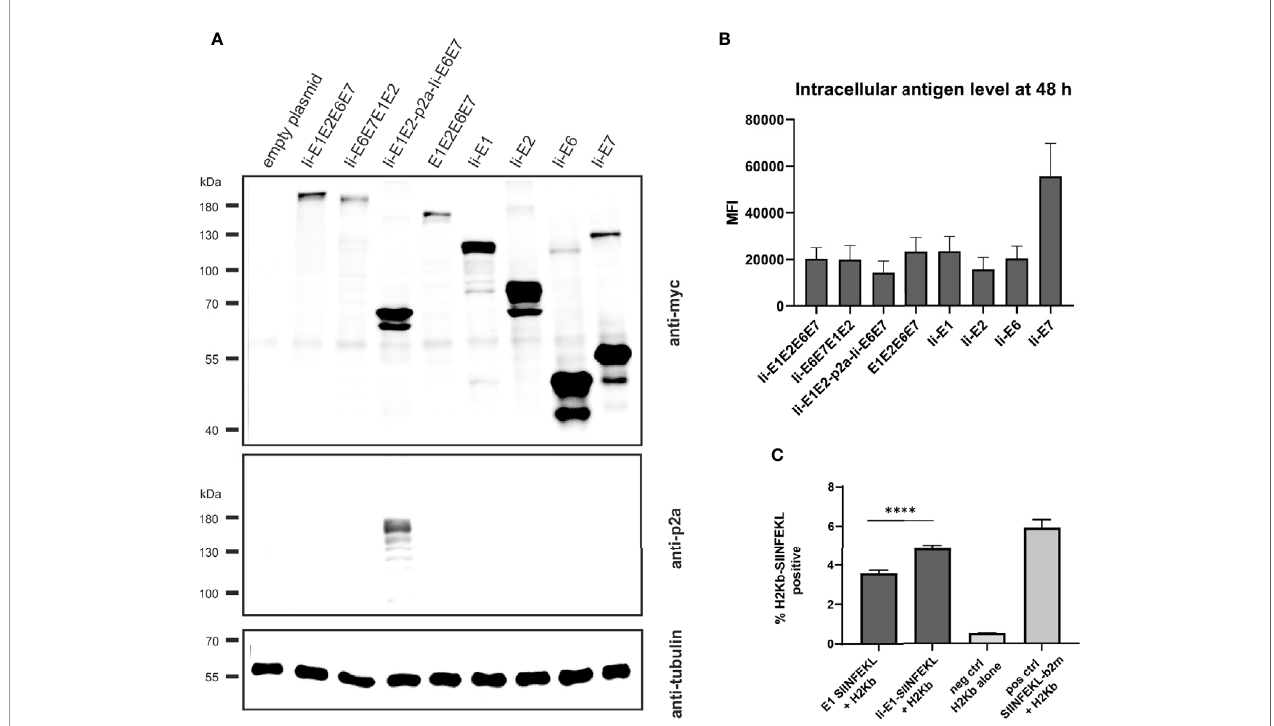
FIGURE 2 | Expression analysis of MfPV3 antigens. (A) Western blot analysis of HEK293T cell lysates 48 h following transfection with equimolar amounts of pURVac DNA vaccines expressing the various MfPV3 antigens. Antigens were detected with anti-myc (upper panel) and anti-p2a-peptide (middle panel) antibodies. Tubulin levels were monitored using an anti-tubulin antibody as loading control (lower panel). (B) Flow cytometry analysis of HEK293T cells 48 hours following transfection with pURVac DNA vaccines. Intracellular staining was performed with anti-myc antibody. Depicted is the mean fl uorescence intensity (MFI) of the average of 3 independent experiments. Error bars indicate standard error of the mean. (C) Co-transfection of HEK293T cells with H2Kb alone or together with pURVac E1- SIINFEKL or Ii-E1-SIINFEKL, respectively. The percentage of SIINFEKL-H2Kb positive cells were determined after 48 hours by fl ow cytometry using an antibody recognizing the SIINFEKL-H2Kb-complex. Error bars indicate standard error of the mean. Light gray bars are negative (no peptide, H2Kb-plasmid only) and positive controls (SIINFEKL- b 2m encoding plasmid + H2Kb), respectively. ****p <